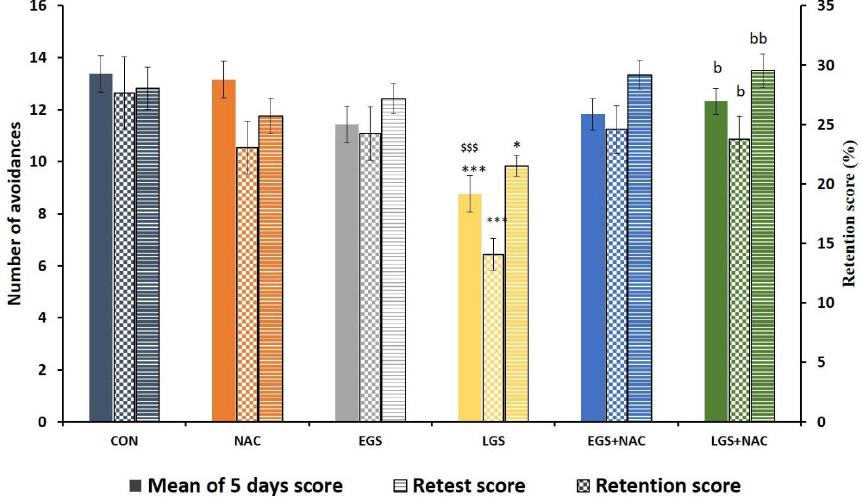
Figure 1. Effect of early and late gestational stress and NAC treatment on avoidance activities by 28-day-old rats in the shuttle box test. One-way ANOVA, Tukey-Kramer Multiple Comparisons Test, each bar represents mean ± SEM, n = 12), CON vs. LGS, * p < 0.05, *** p < 0.001; LGS vs. LGS + NAC b p < 0.05, bb p < 0.01, NAC vs. LGS, $$$ p <